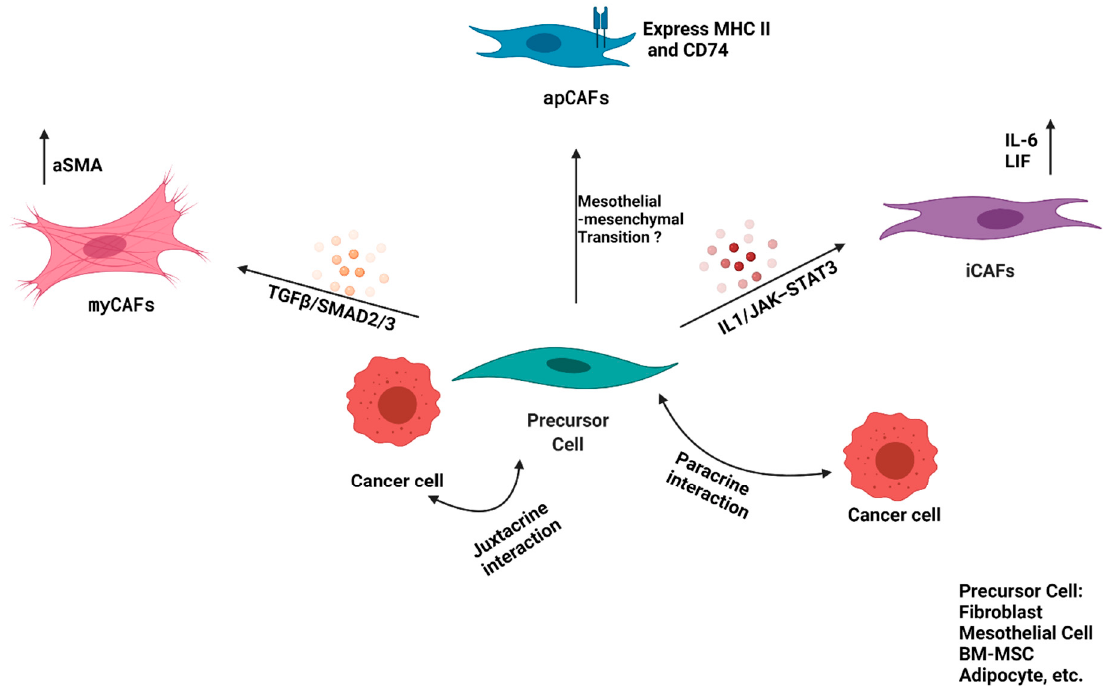
Figure 2. CAF Heterogeneity. Illustration of CAF heterogeneity, showing differentiation of precursor cells, such as resident fibroblast or mesothelial cells, or BM-derived MSCs, etc., into myCAF, iCAF, and apCAF, with reported probable